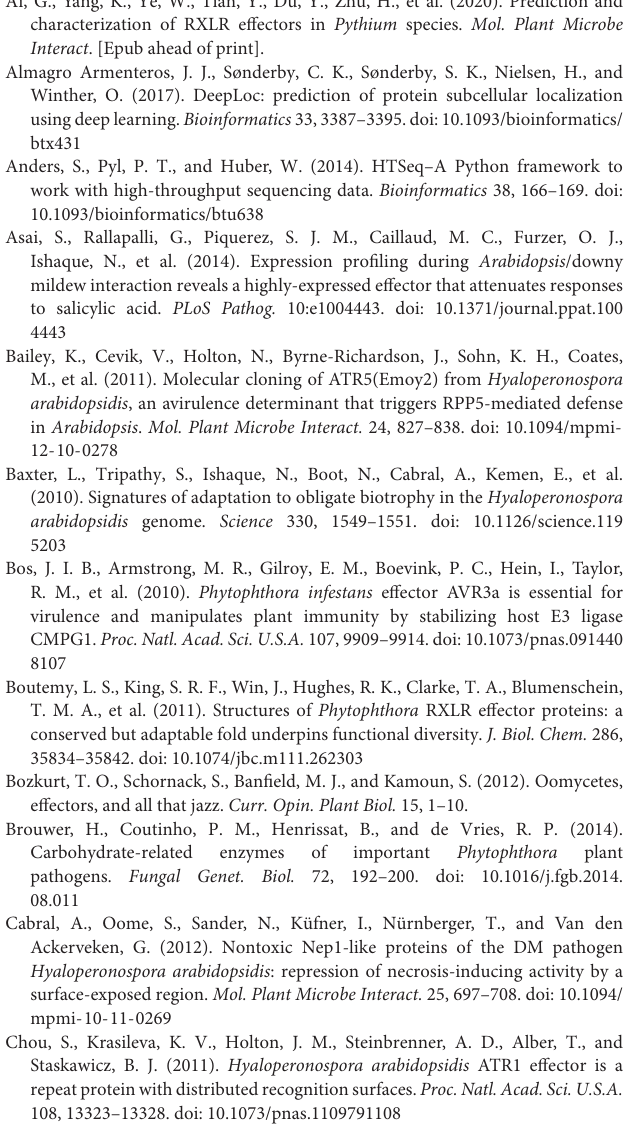
TABLE S15 | List of core effectors in Pseudoperonospora